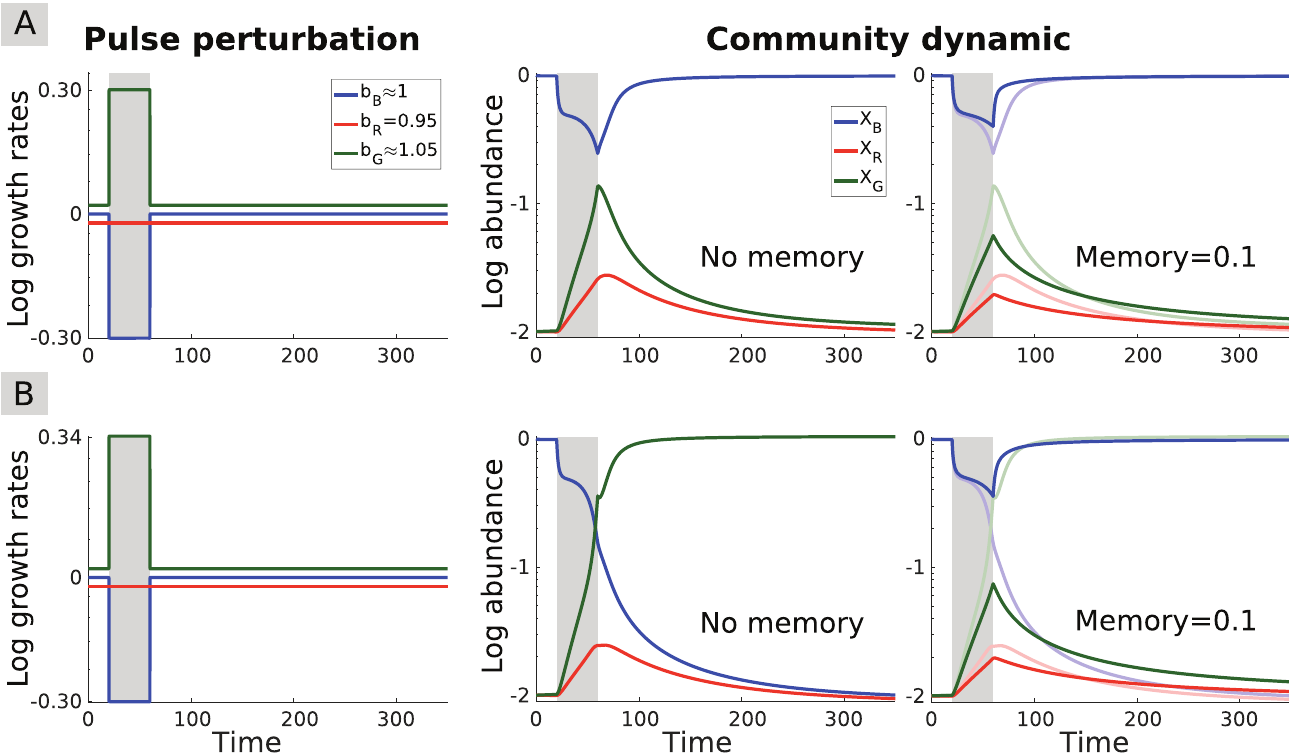
Fig 2. Impact of commensurate memory on community resistance and resilience. (A) A pulse perturbation is applied to the community (left panel): the growth rate of the blue species is lowered while that of the green species is simultaneously raised. The perturbation temporarily moves the community away from its initial stable state, characterized by blue species dominance (middle panel). Introducing commensurate memory (right panel) increases resistance to perturbation since the community is not displaced as far from its initial state compared to the memoryless case (shown in superimposition). The effect on resilience depends on the time scale considered: while memory initially hastens the recovery after the perturbation, it slows down the later stages of the recovery (starting around the time step 150). (B) A slightly stronger pulse perturbation is applied (left panel), triggering a shift toward an alternative stable state dominated by the green species (middle panel). Memory can prevent the state shift (right panel), thus increasing both resistance and resilience to perturbation.